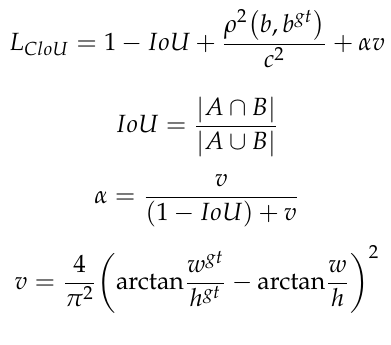
Figure 4. Sample labeling of polished rice images: ( a ) whole image labeling style of other algorithms; ( b ) whole image labeling style of YO-LACTS; ( c ) small icon labeling style of YO-LACTS.